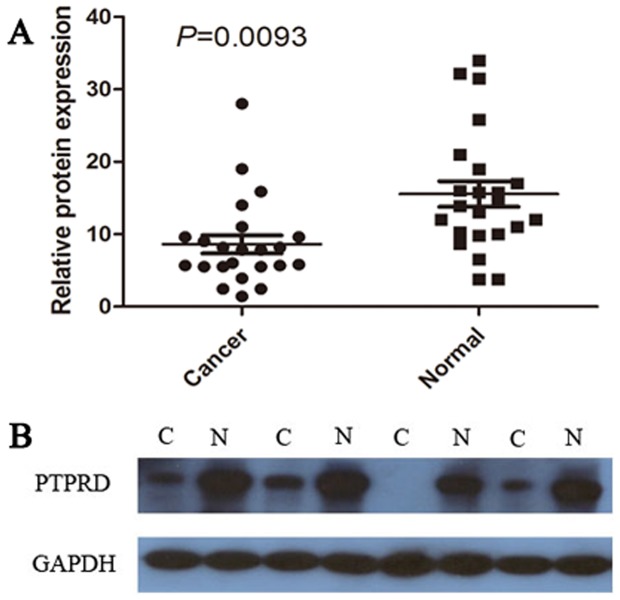
Decreased protein expression of PTPRD in gastric adenocarcinoma was assessed by western blotting.(A) Relative PTPRD protein expression levels in GC tissues and the matched normal paracancerous tissues (PTPRD/GAPDH, n = 23, P = 0.0093). Horizontal lines represent the mean. (B) Representative results of PTPRD protein expression in 4 paired GC tissues and the matched adjacent noncancerous tissues (C, GC tissues; N, matched noncancerous gastric mucosa).